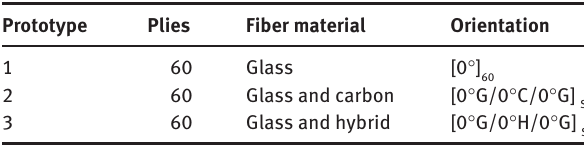
Table 7: Specifications of the composite-based leaf spring systems manufactured.